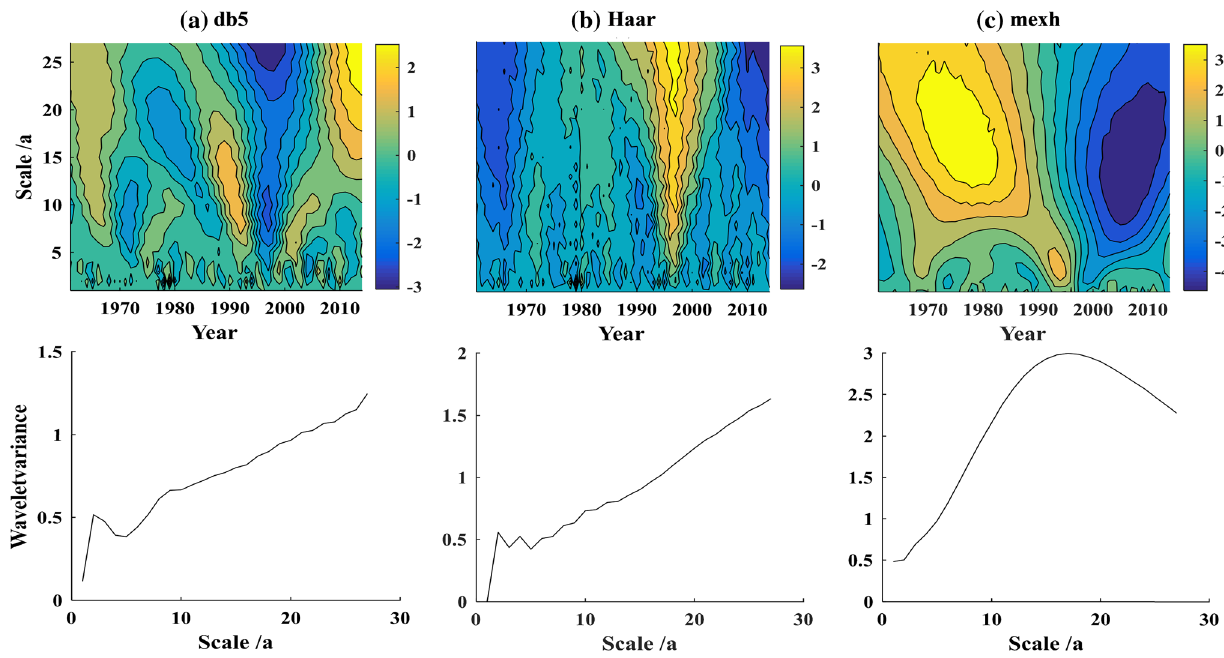
Fig. 11 Time–frequency distributions and variance diagrams for different wavelet basis transform coefficients for the Heihe River Basin during